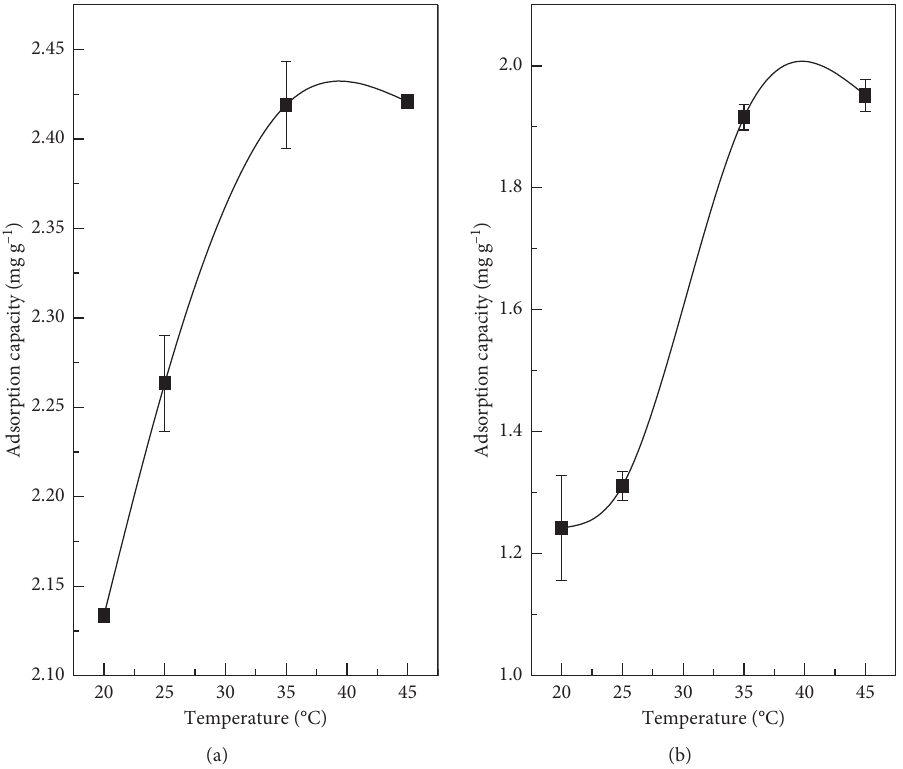
Figure 9: Effect of temperature on the adsorption of wastewater (a) Cu (II) and (b) Cd (II) by SACL (experimental condition: Cu (II) concentration � 200mg · L − 1 ; Cd (II) concentration � 200mg · − 1 ; contact time � 180min; amount of adsorbent � 4 g; pH � 4; and agitation speed � 150rpm) (error bars represent the standard deviation of three replicates). Table 3: Fitting parameters of two kinetic models for Cu (II) and Cd (II) adsorption by SACL. Pseudo-first-order kinetic model